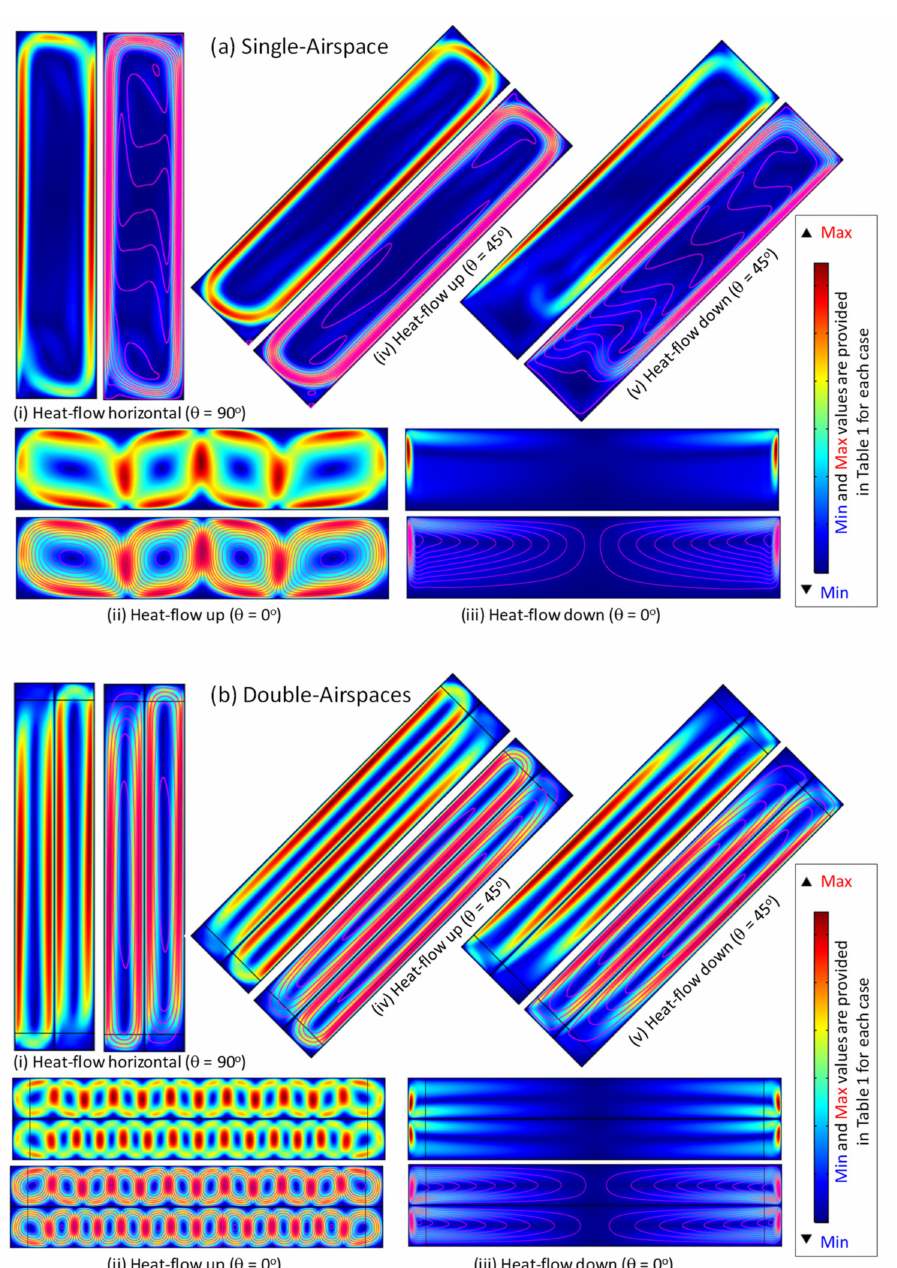
Figure 7. Distributions of resultant velocity and velocity field streamlines in ( a ) a single airspace and ( b ) double airspaces (H = 406 mm (16 inches) and δ = 89 mm (3.5 inches), T H = 32.2 ◦ C (90 ◦ F), T L = 15.6 ◦ C (60 ◦ F), E =